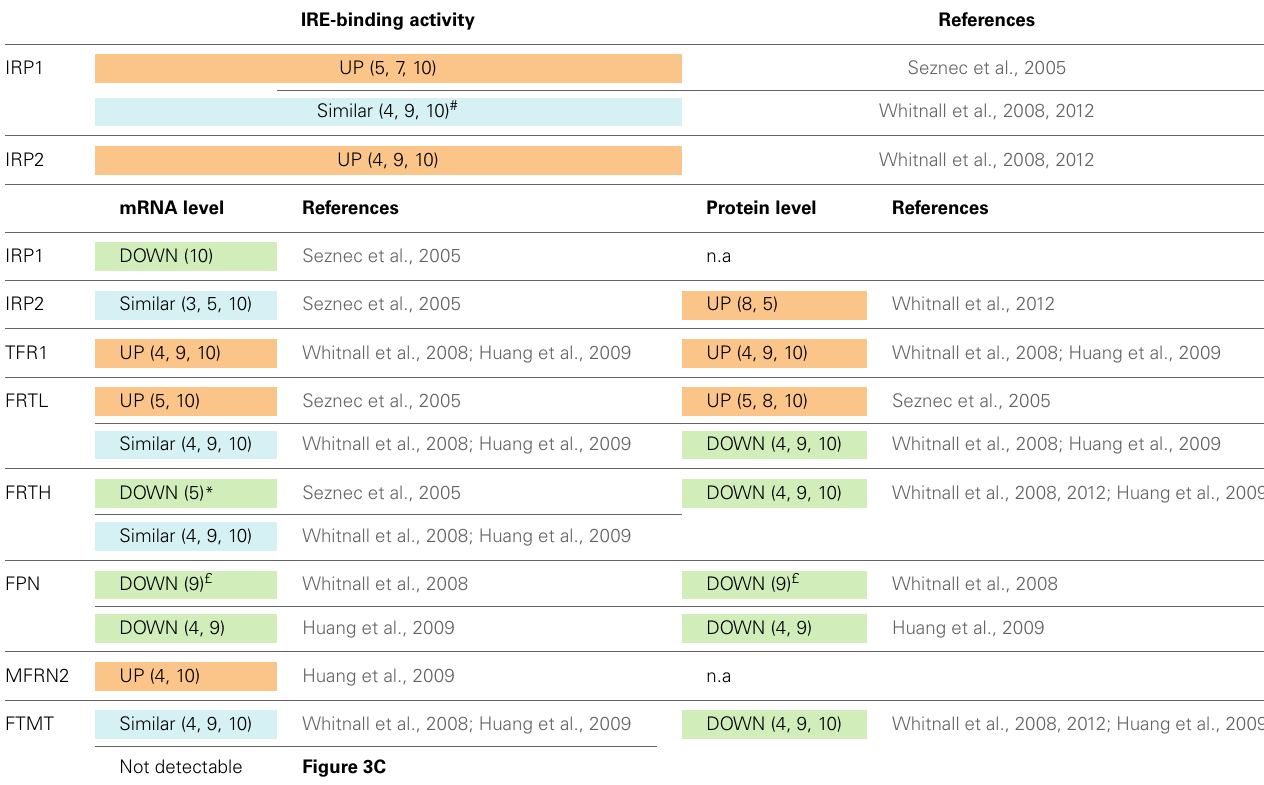
Table 1 | Modifications in iron-related gene expression and activity in MCK mice. IRE-binding